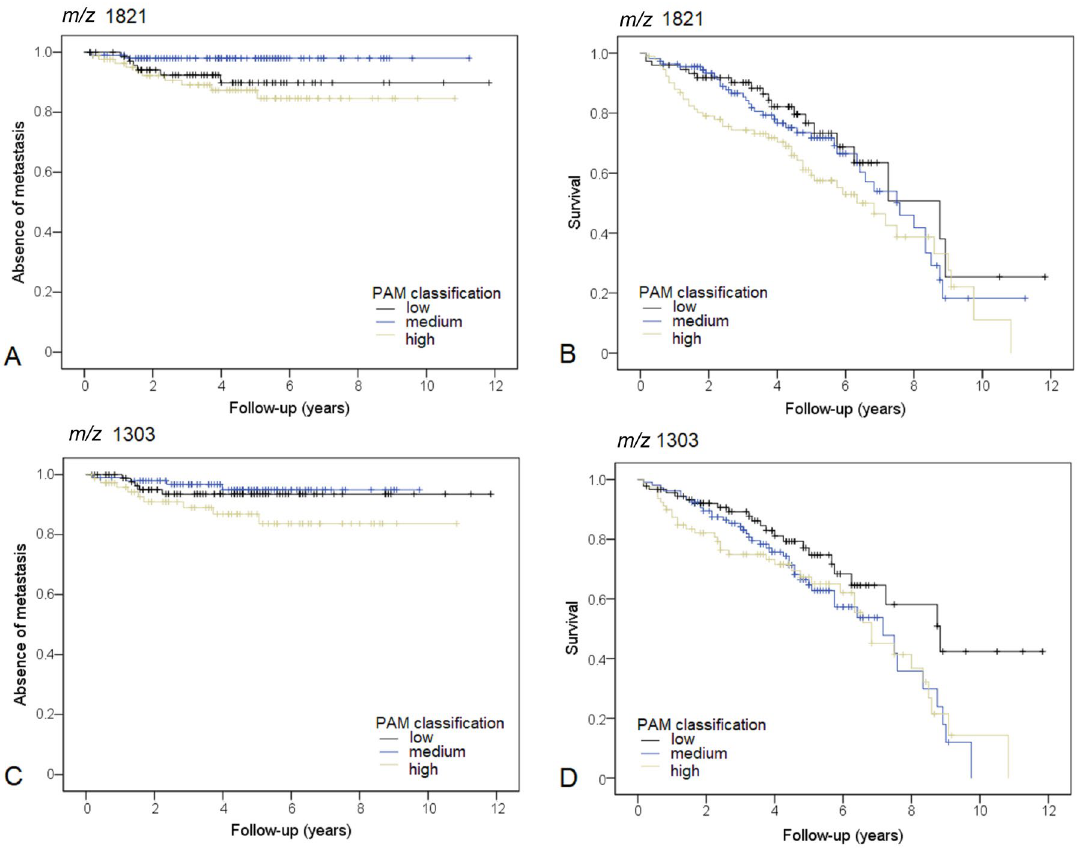
Figure 1. ( A ) KM curve for the occurrence of distant metastasis. Patients are stratified based on PAM classification of m / z 1821.83. ( B ) KM curve for patient survival. Patients are stratified based on PAM classification of m / z 1821.83. ( C ) KM curve for the occurrence of distant metastasis. Patients are stratified based on PAM classification of m / z 1303.06. ( D ) KM curve for overall survival. Patients are stratified based on PAM classification of m / z